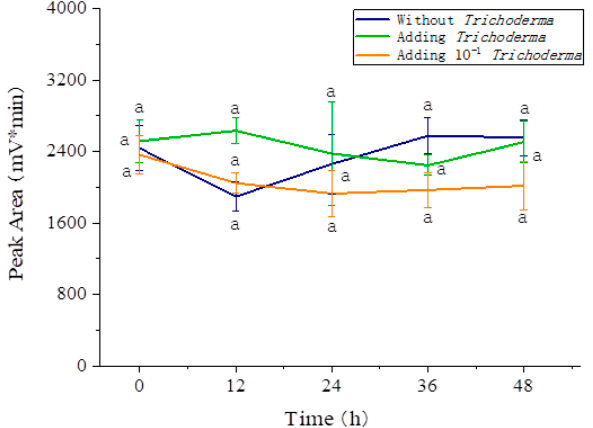
Figure 7. Effect of colony numbers of Trichoderma on the degradation of amygdalin.